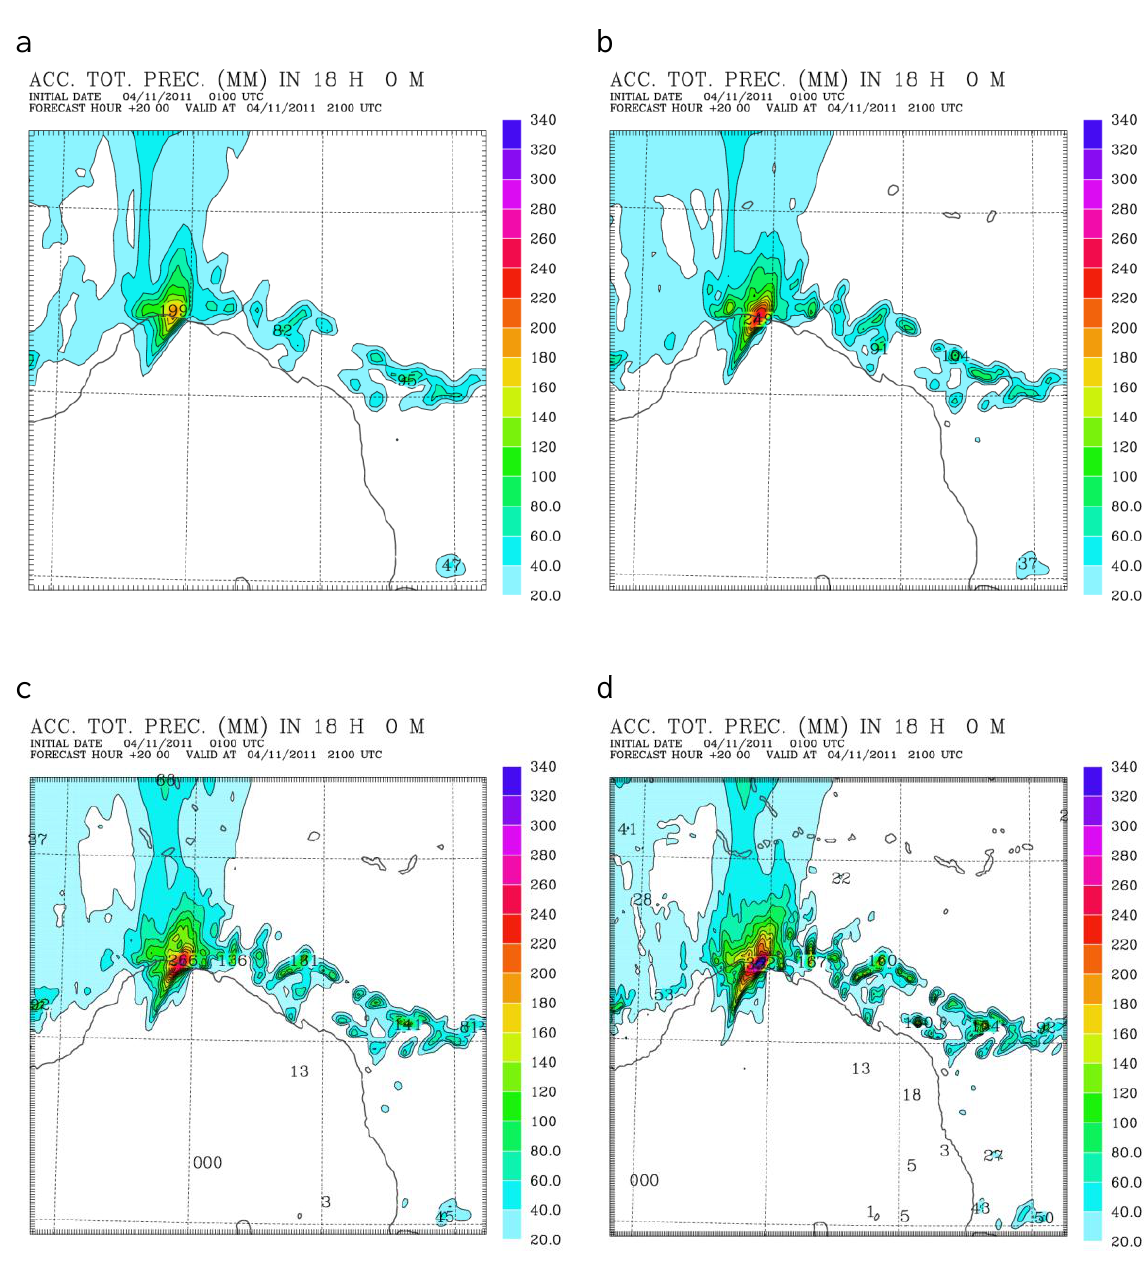
Figure 9. Precipitation accumulated in the 18h period starting at 03:00UTC of 4 November 2011 in MOLOCH forecast runs, based on ECMWF-IFS analysis at 00:00UTC of the same day, for different grid mesh sizes: 3.0km, max. 199mm (a) , 2.0km, 249mm (b) , 1.5km, 266mm (c) , 1.0km, 352mm (d) . Contour interval: 20 mm.